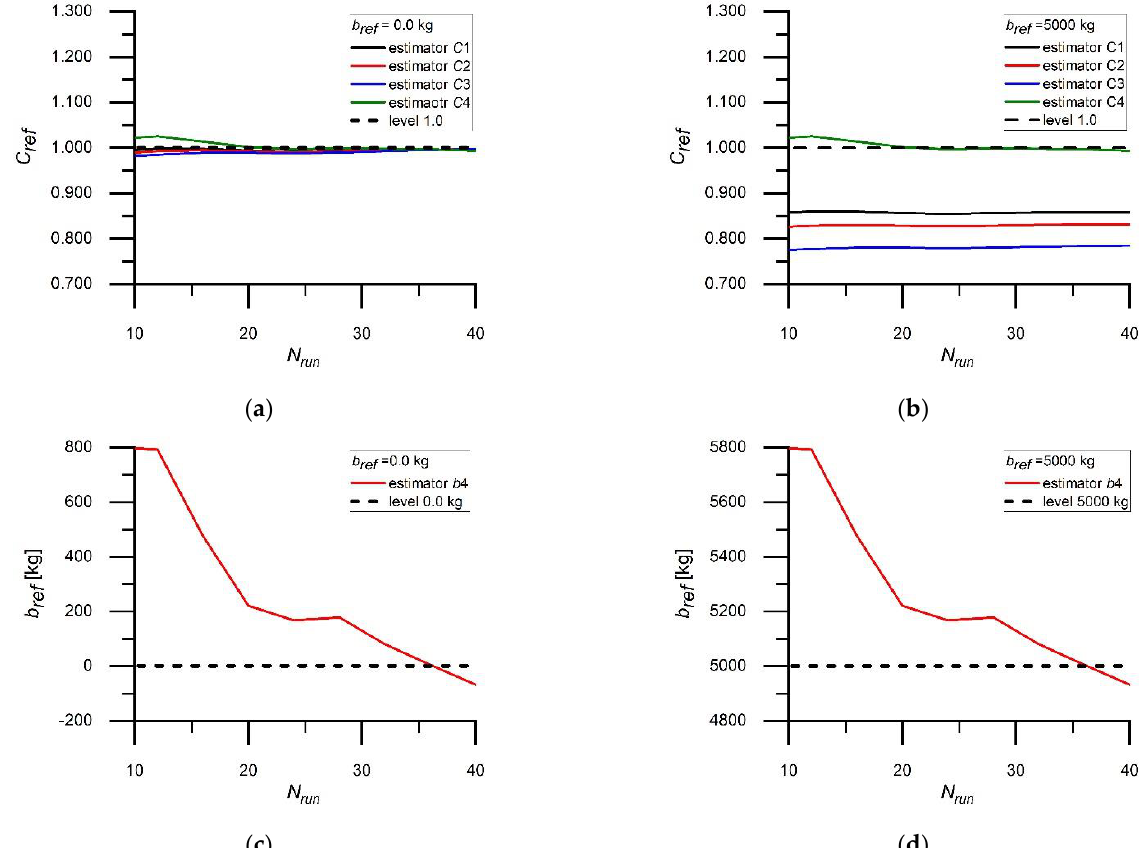
Figure 8. Estimation of the calibration coefficients ( a , b ) — 𝐶 𝑟𝑒𝑓 ; ( c , d ) — 𝑏 𝑟𝑒𝑓 , obtained using different estimators, respectively, for 𝑏 𝑟𝑒𝑓 = 0 kg and 𝑏 𝑟𝑒𝑓 = 5000 kg, as a function of the number of test vehicle runs 𝑁 𝑟𝑢𝑛 .